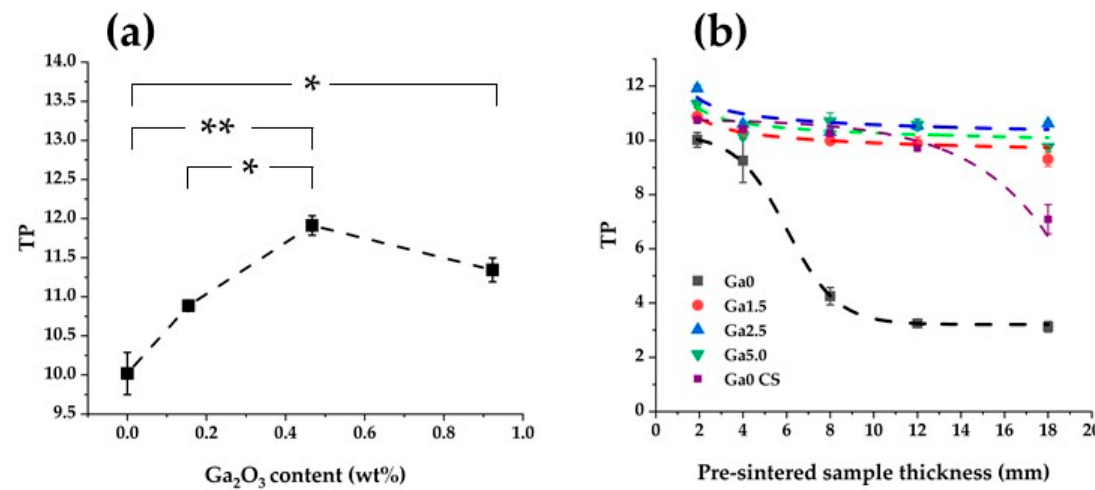
Figure 9. Relationship between TP of each sample and ( a ) Ga 2 O 3 concentration, ( b ) Pre-sintered sample thickness. The asterisk and two asterisks in ( a ) refer to statistical significance. Ga0 CS in ( b ) indicates conventional sintered Ga0, the data of which is taken from previous study [15].